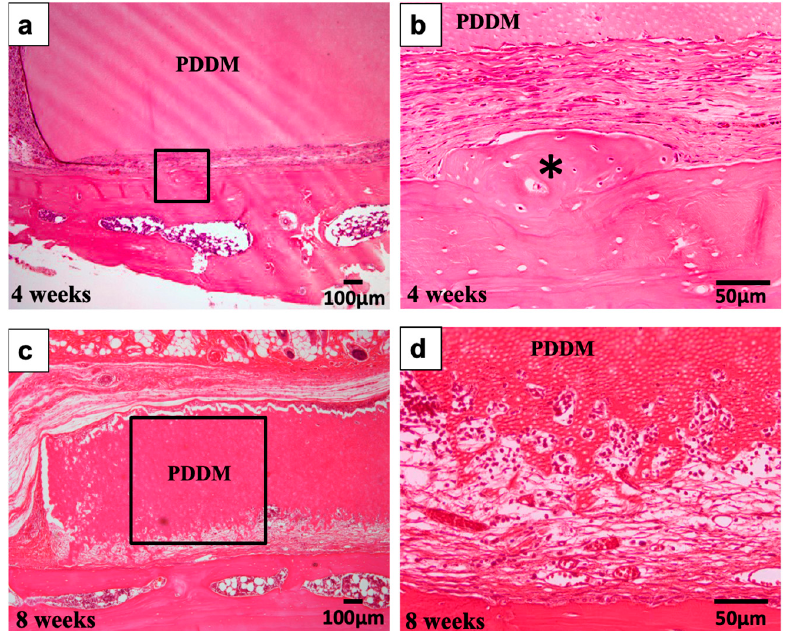
Figure 7. Histological images of non ‐ scratched skull without periosteum at 4 weeks ( a , b ) and 8 weeks ( c , d ) as controls. ( a ) Fibrous connective tissues between PDDM block and Skull. ( b ) Higher magnification of frame in ( a ). Locally, reactive bone formation (*). Acellular original bone indicating necrotic bone. ( c ) No bony bridge. Note: marrow space ‐ closing. Absorption of bottom surface of block. ( d ) Higher magnification of frame in ( c ). Wavy surface of PDDM showing a different structure from skull surface. PDDM: Partially demineralized dentin matrix.